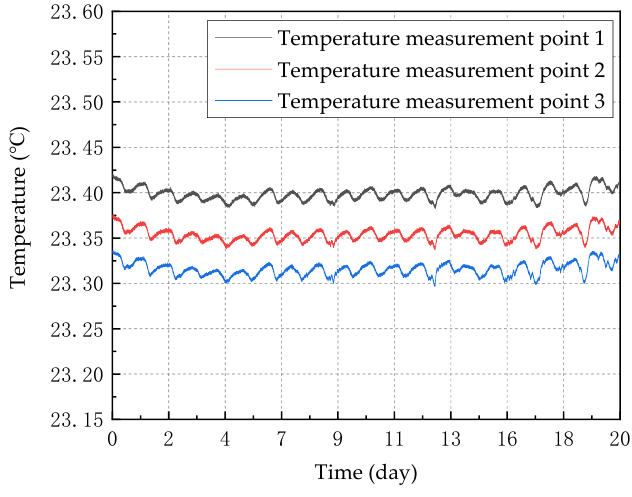
Figure 5. Temperature measurement